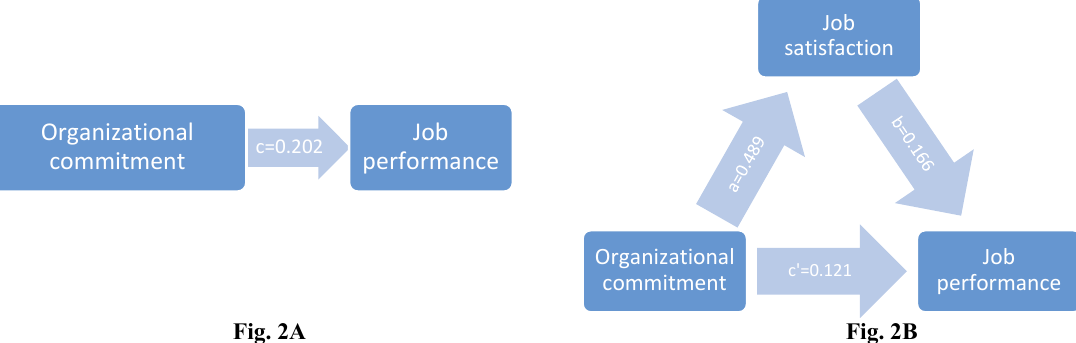
Job performance